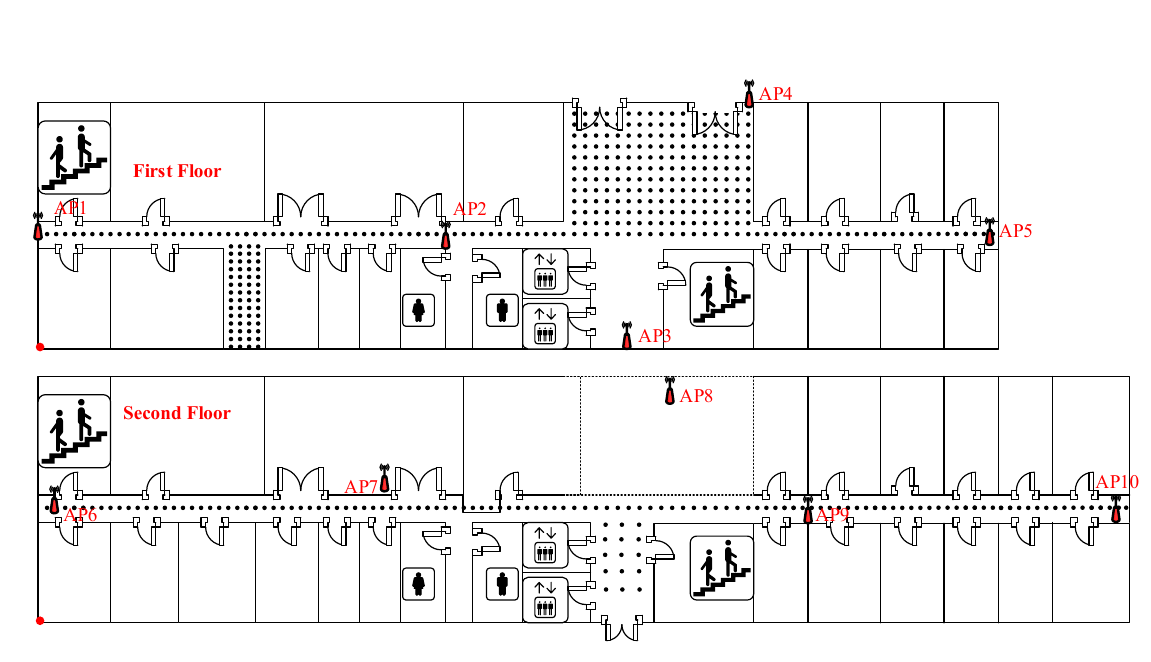
Figure 5. Floors plan